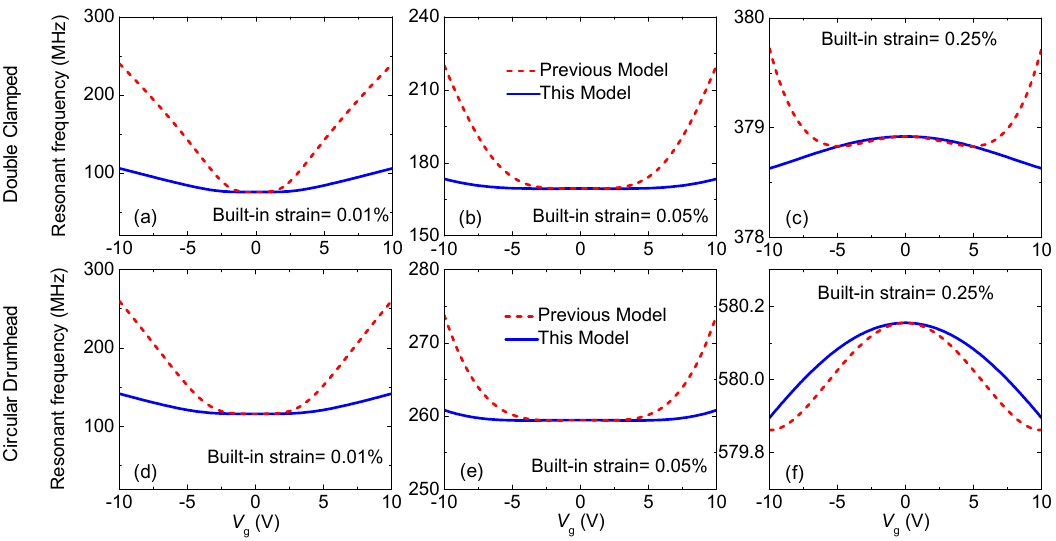
Figure 3. Three typical frequency tuning behaviors for both a doubly clamped graphene resonator (upper row) and a circular drumhead graphene resonator (lower row) with varying built-in strain of ( a , d ) 0.01%, ( b , e ) 0.05%, and ( c , f ) 0.25%. The red dashed lines show previous modeling and blue solid lines show this model by assuming that effective mass ratio = 2, air gap z 0 = 300 nm, length L = 1 μ m and diameter D = 1 μ m, respectively.